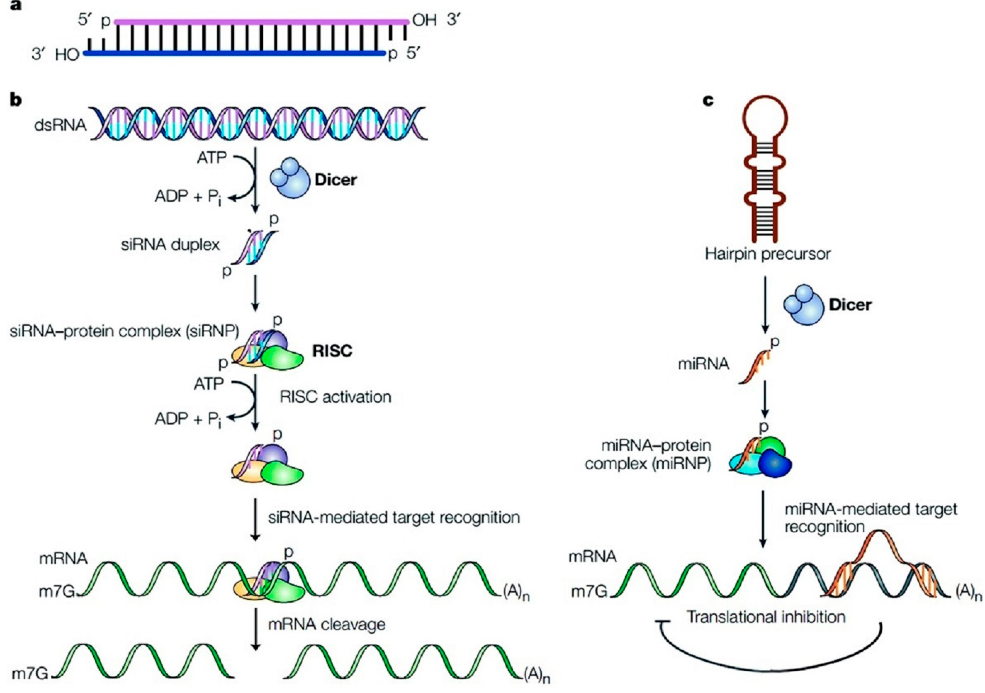
Figure 1. ( a ) Structure of siRNA; ( b ) siRNA pathway; ( c ) miRNA pathway (Reproduced with permission from [8]. Copyright the Royal Society of Chemistry, 2003).